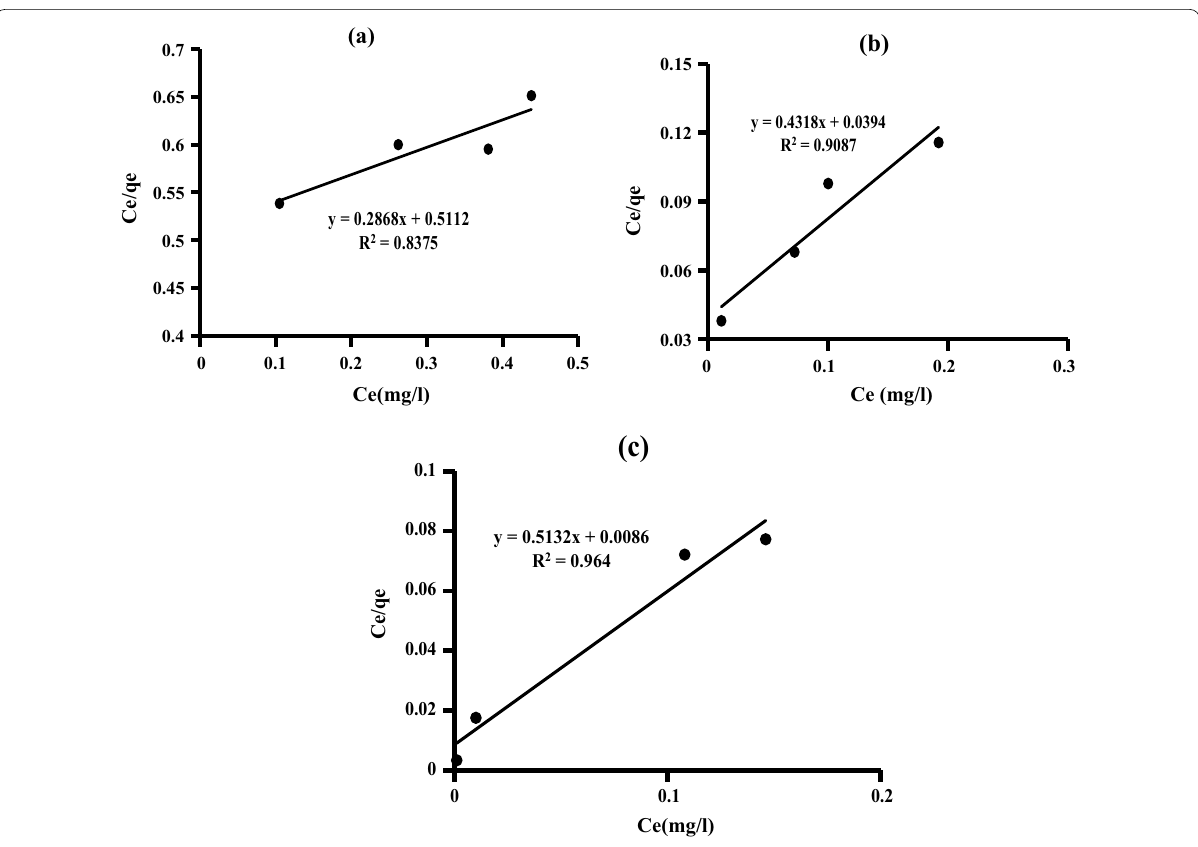
Fig. 10 Langmuir isotherm of copolymer ( a ), aniline graft ( b ) and 2‑chloroaniline graft ( c